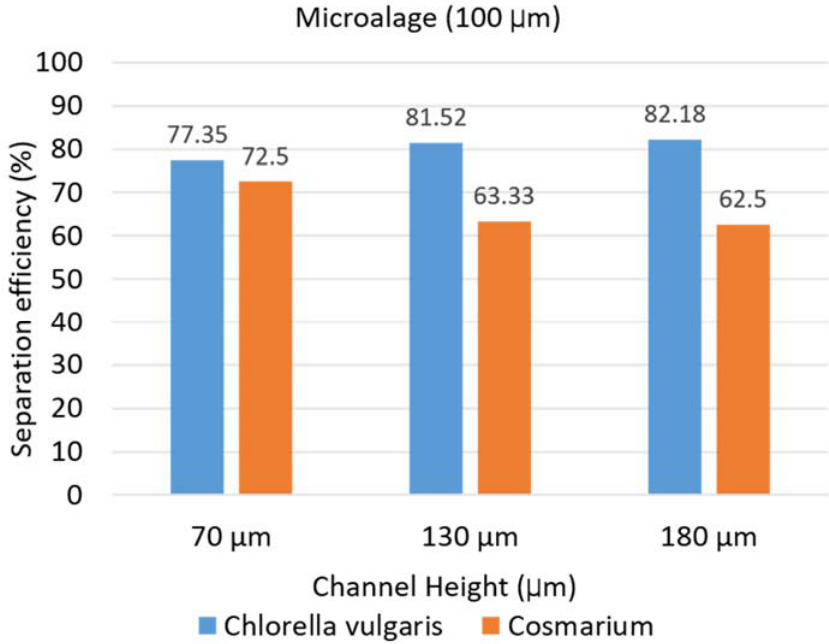
Figure 9. Separation efficiency of microalgae in a spiral channel of width 100 µm, between the three channel heights—70, 130, and 180 µm.